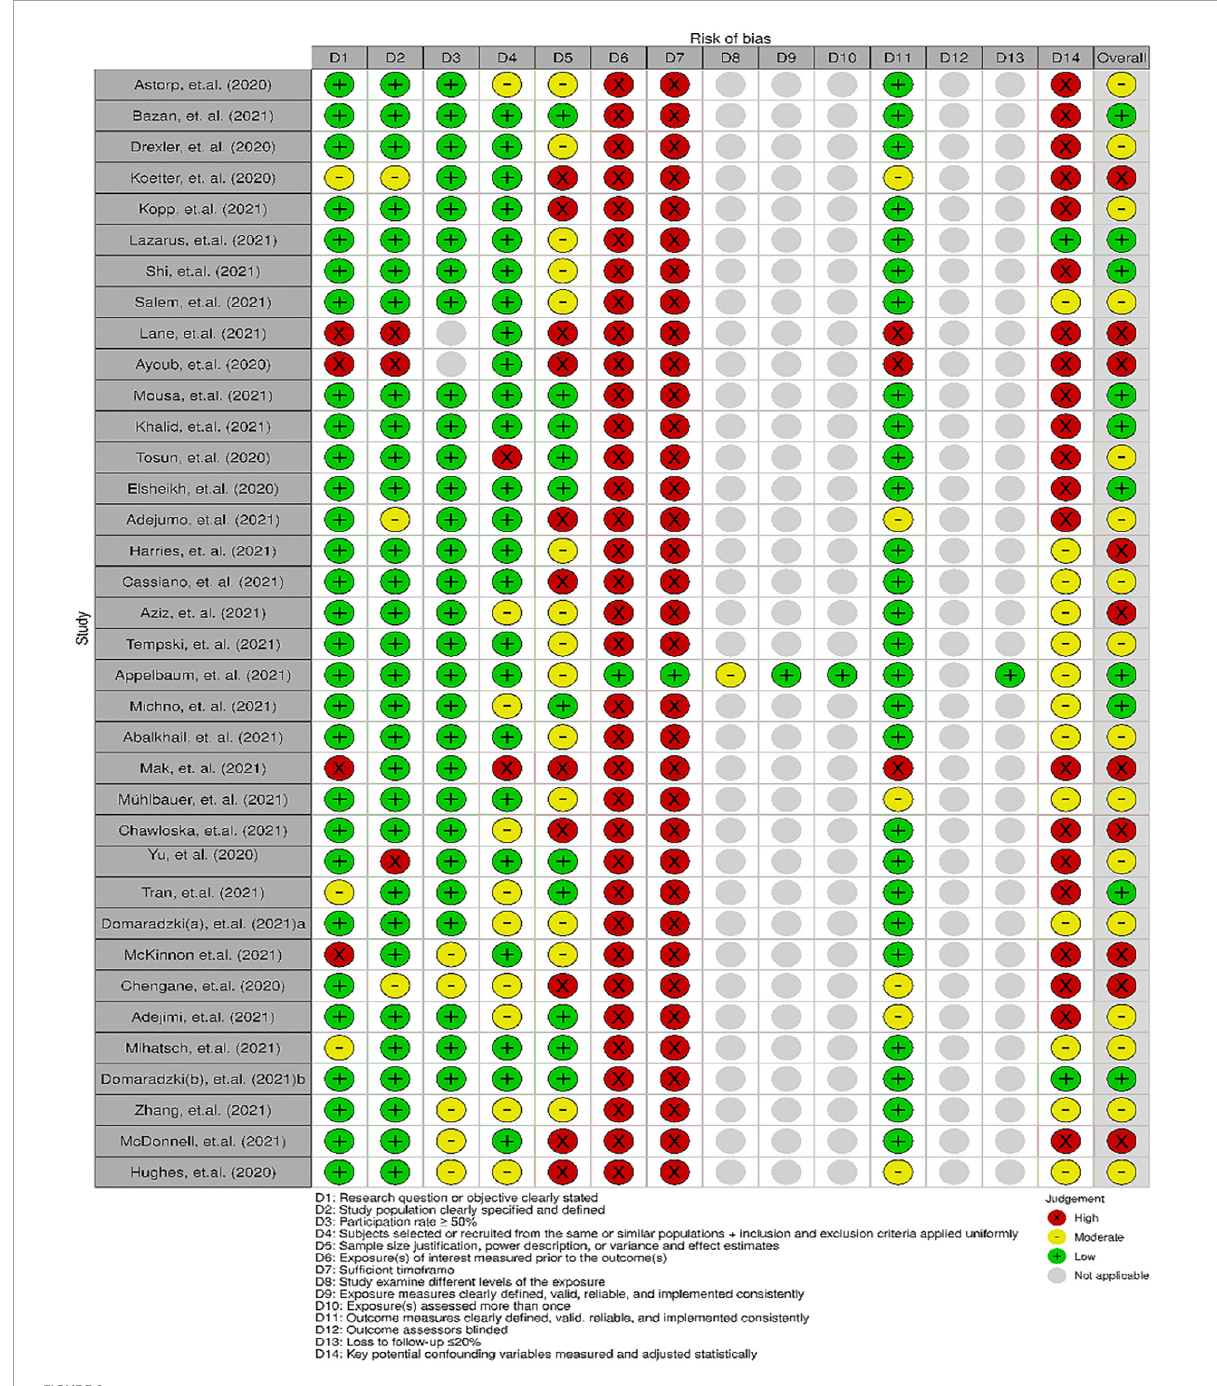
(41). A chain-mediation analysis of this phenomenon outlined four essential topics: altruistic motivation, prosocial encouragement, self-moral cognition, and reward